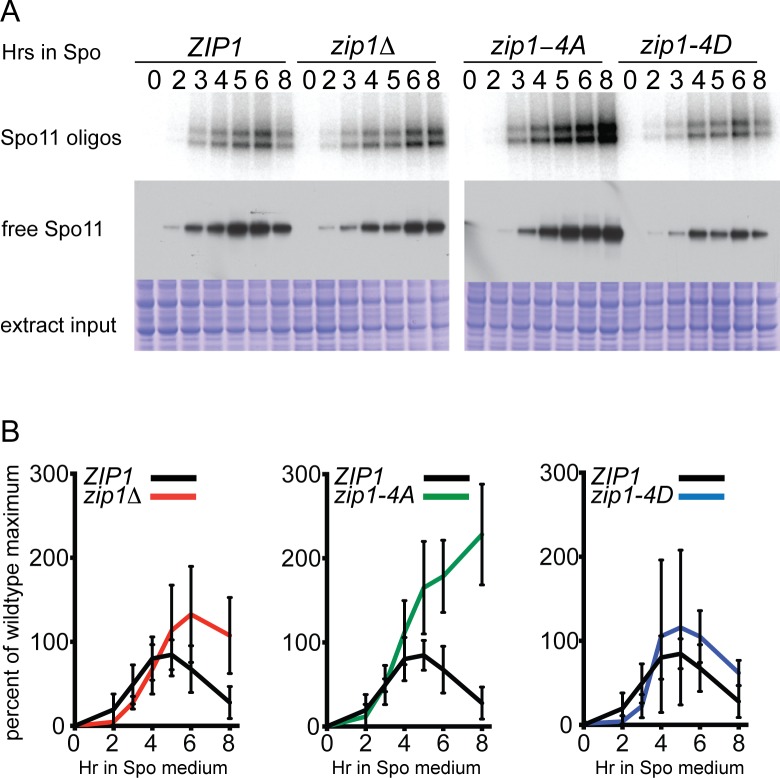
Quantification of DSBs in various zip1 mutants using Spo11 oligonucleotides.Time courses of meiotic cultures of ZIP1 (NH2311), zip1::LEU2 NH2312, zip1-4A (NH2313), and zip1-4D (NH2314) containing Protein A-tagged Spo11 were performed in parallel as described in [14]. (A) Spo11-Protein A was immunoprecipitated using Protein A antibodies, and the covalently attached radioactively end-labeled oligonucleotides were detected by autoradiography (top panel). Free Spo11 was detected by probing immunoblots of the extracts with Protein A antibodies (middle panel). Extracts used for Spo11 immunoprecipitation were fractionated by SDS-PAGE and proteins stained with Coomassie Brilliant Blue to show that equivalent amounts of extract were used as input for the immunoprecipitation reactions (bottom panel). (B) Quantification of mean Spo11 oligonucleotide levels from four independent experiments. Error bars represent the standard deviation. Mutants are plotted with WT data collected in parallel.